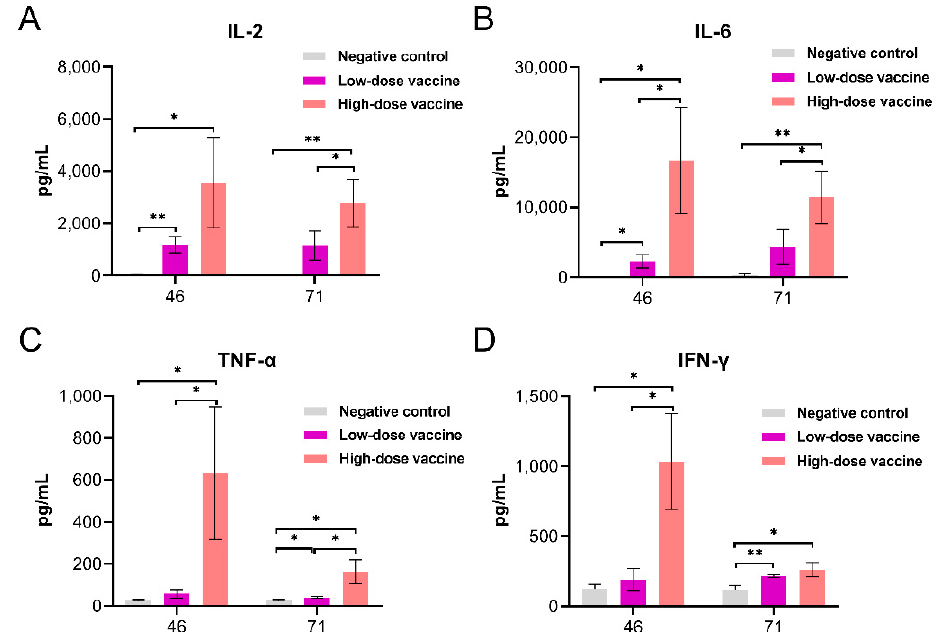
Figure 4. Expression of cytokines in peripheral blood after immunizations. ( A ) IL-2, ( B ) IL-6, ( C ) TNF- α and ( D ) IFN- γ . The data are presented as the means ± s.d. ( n = 10), * p < 0.05, ** p < 0.01.